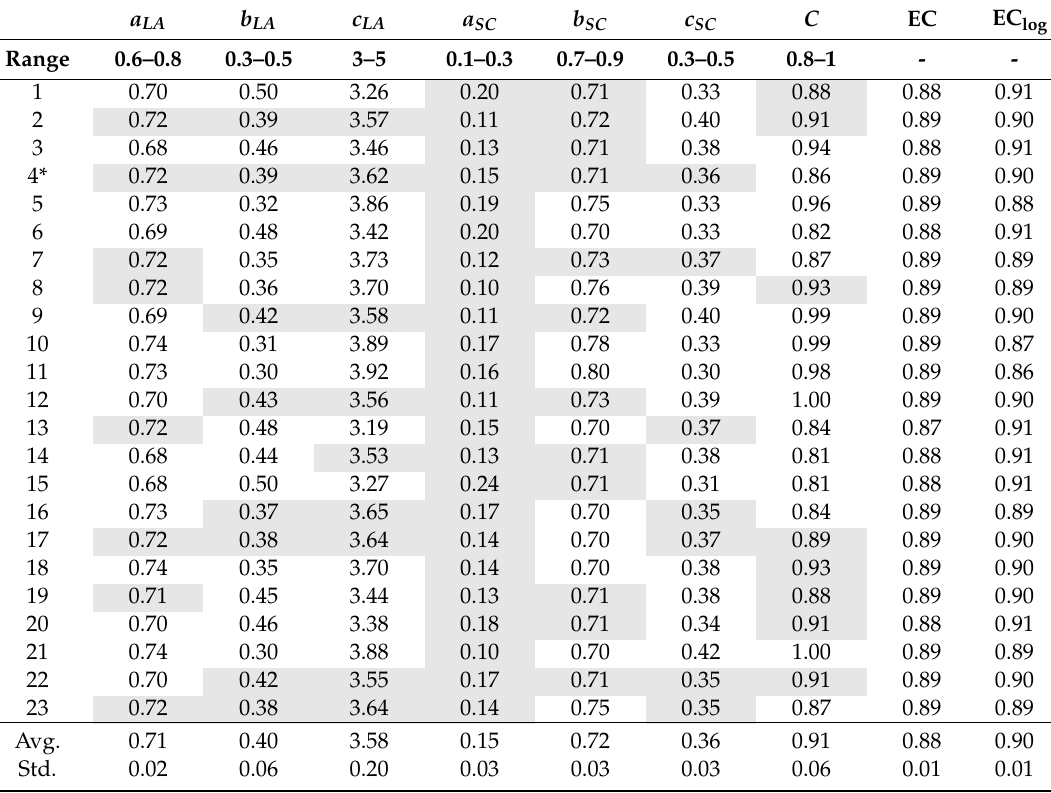
Table 3. Best-fit parameters for the landslide model and the sediment transport